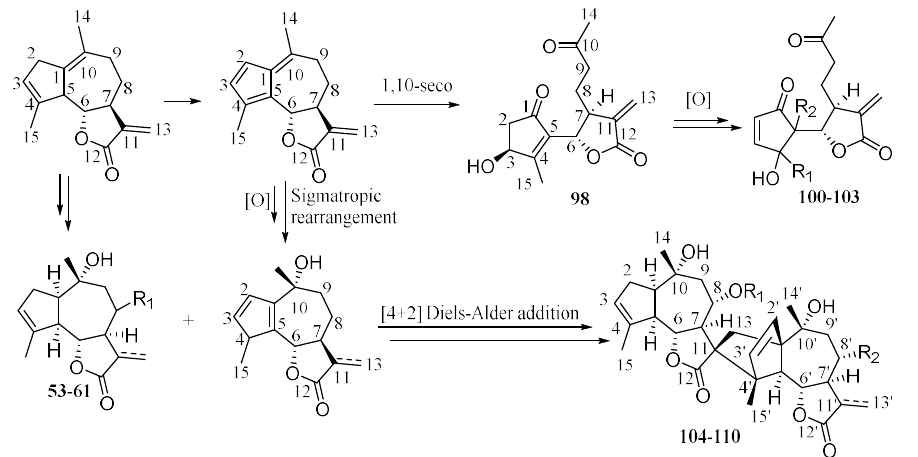
Figure 8. The plausible biosynthetic pathway of 1,10-seco guaianolides and disesquiterpenoids.